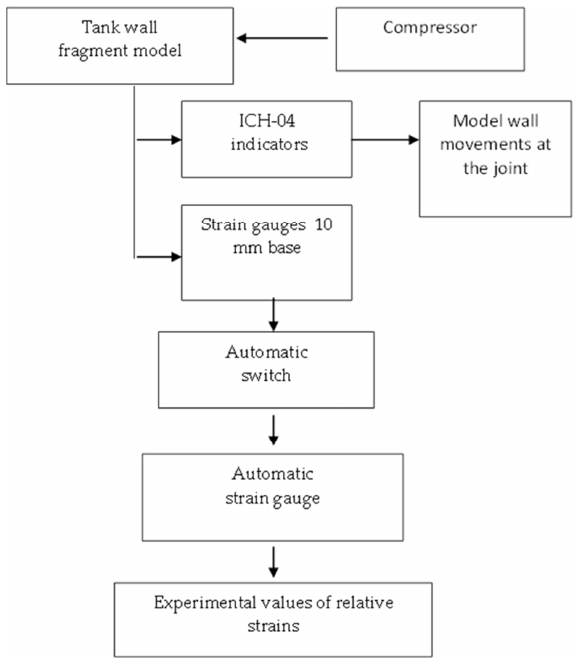
Figure 4. Block diagram of the experiment.